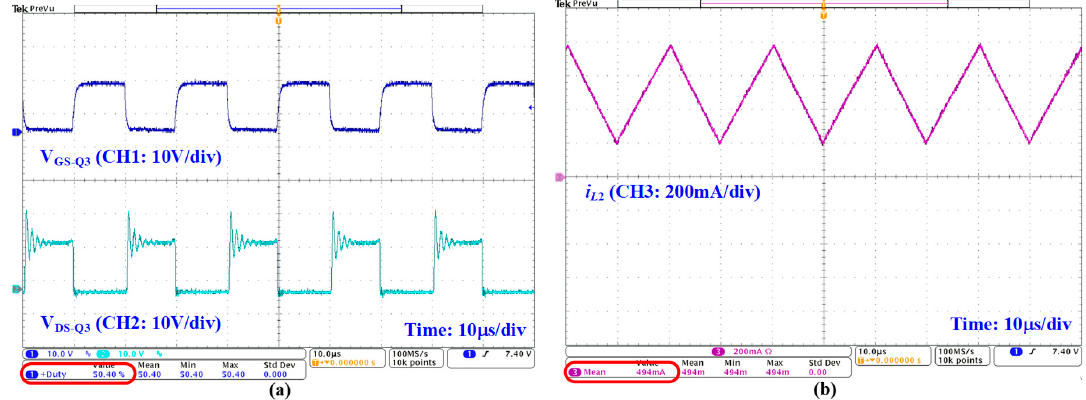
Figure 16. Measured waveforms of PCL 2 with the AVDC method: ( a ) switch voltages of V GS-Q3 and V DS-Q3 , ( b ) inductor current of i L 2 .